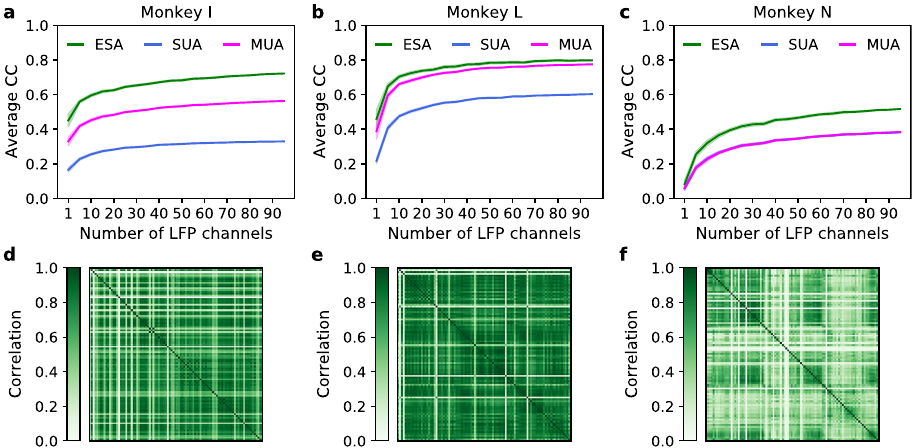
Figure 4. Impact of different number of LFP channels on inference performance (measured in average CC) across subjects. ( a – c ) Comparison of average CC among ESA, SUA, and MUA from monkey I, L, and N, respectively. The shaded areas represent 95% confidence intervals from 30 iterations. ( d – f ) Comparison of LFP interchannel correlation for monkey I, L, and N,